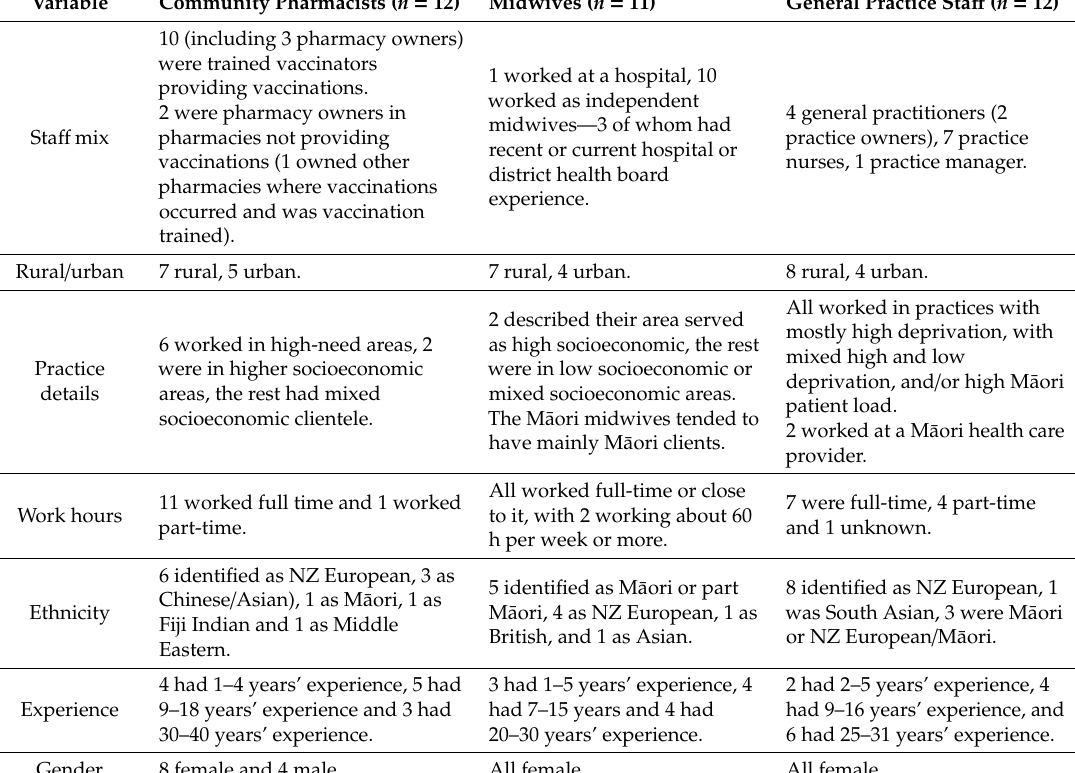
Table 2. Characteristics of the enrolled and interviewed health care practitioners ( n =